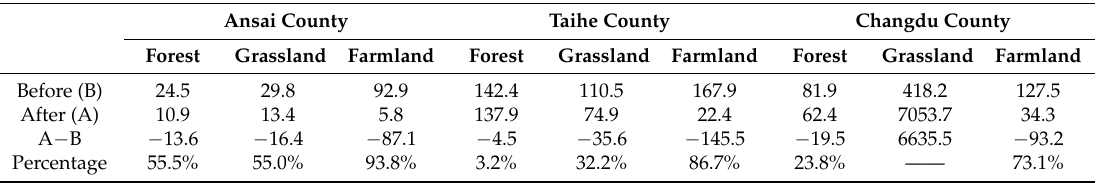
Table 5. Standard deviation of the ranges.